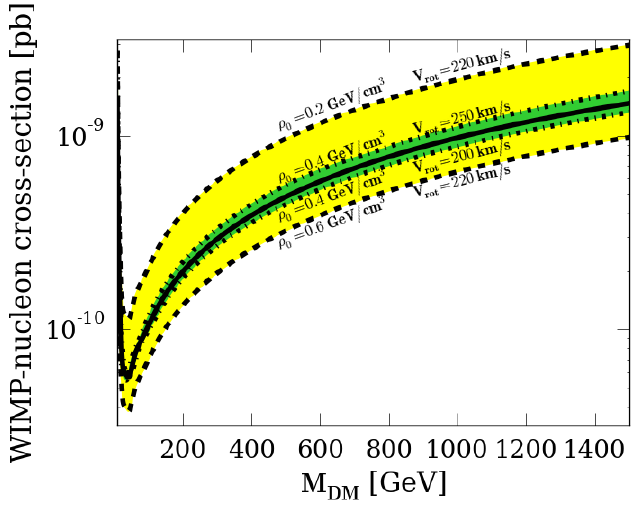
Figure 3 . XENON1T 90% C.L. spin-independent WIMP -nucleon cross section upper limit for (cid:26) 0 = 0 : 4 GeV/cm 3 and v rot = 220 km/s (black plain line). Uncertainties on these values are shown by varying independently the DM local density (yellow band) and the disc rotation velocity (green band).